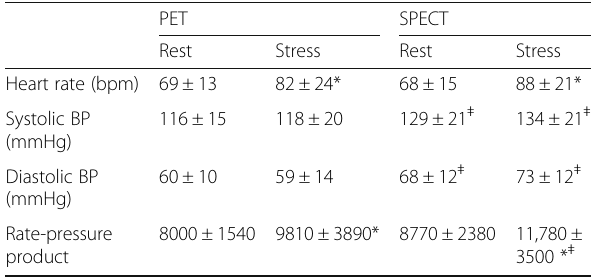
Table 2 Subject haemodynamic parameters in PET and SPECT studies PET SPECT